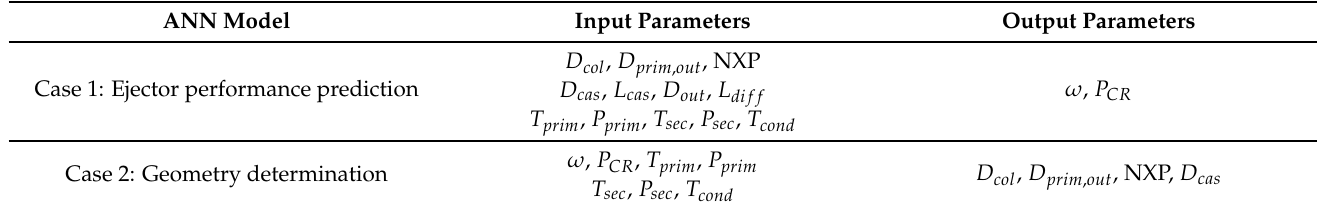
Table 3. Description of the input and output of the data for the two ANNs